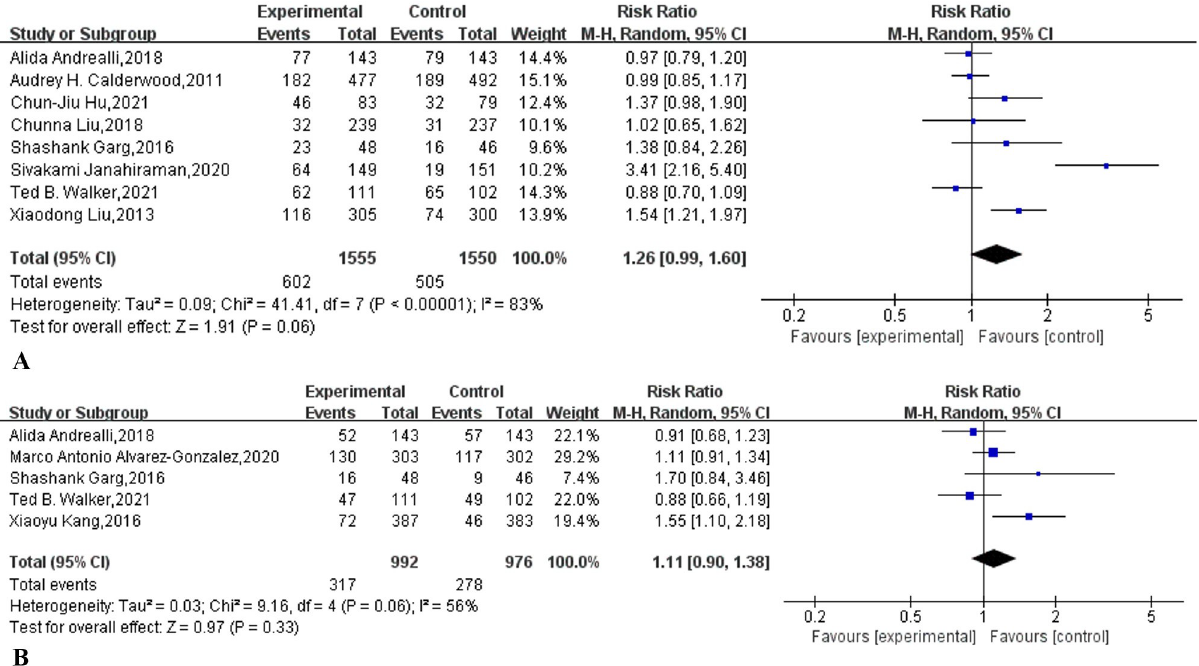
Fig 8. Forest plot comparing (A) polyp detection rate (PDR) and (B) adenoma detection rate (ADR) supplementary education combined with traditional education and traditional education alone.